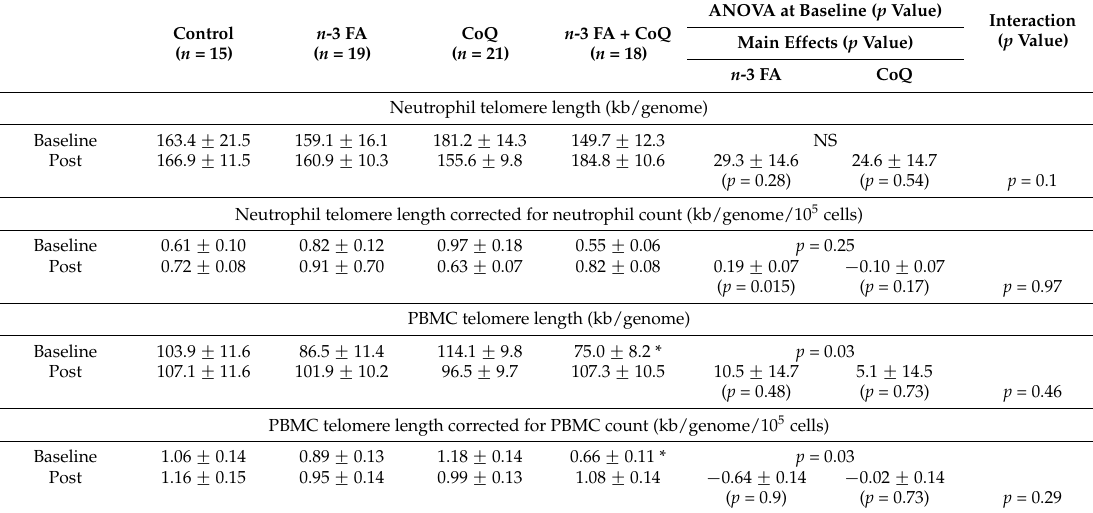
Table 1. Neutrophil and peripheral blood mononuclear cells (PBMC) telomere length before and after correction for cell counts at baseline and after 8 weeks intervention.